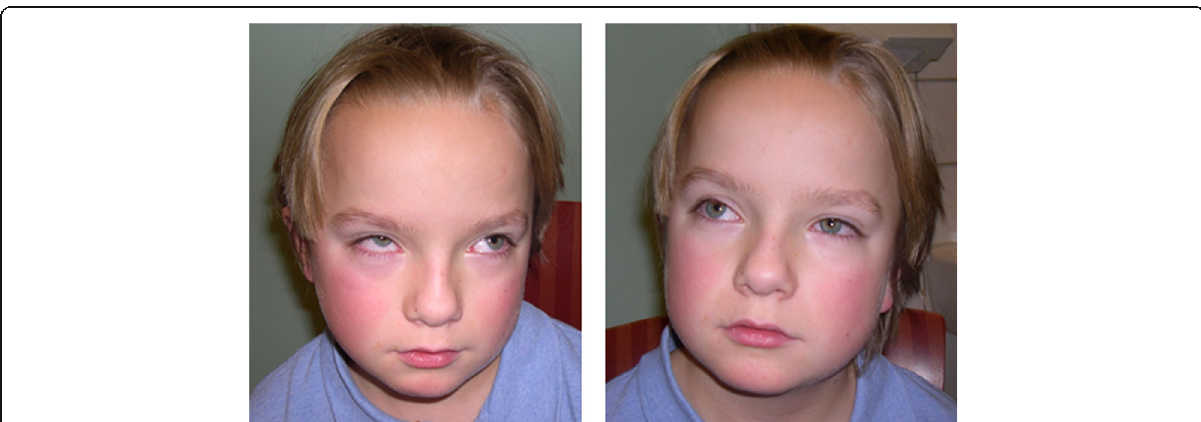
Fig. 1 Photograph of the patient at the age of 11 years showing Duane (retraction) anomaly: when gazing to the left, the globe of the adducting right eye is retracting and when gazing to the right, the globe of the adducting left eye is retracting. Lateral eye movement to either side is limited because the corresponding abducens nerve nucleus inadequately innervates the lateral rectus muscle, resulting in globe retraction and